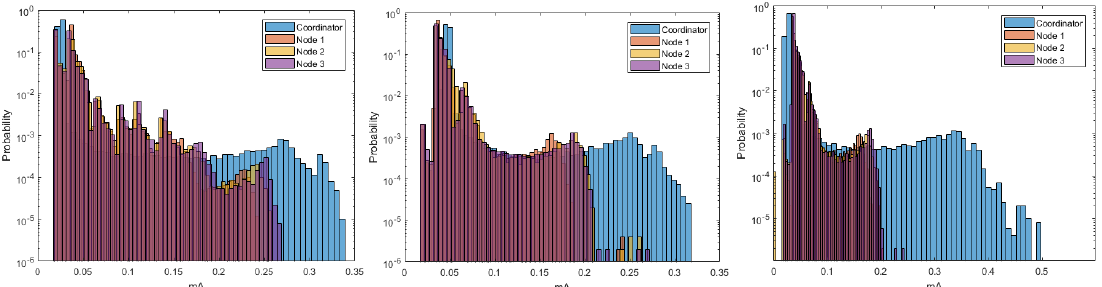
Figure 13. Histograms for ZigBee network. From left to right: at 9600, 19,200, and 57,600 bauds.